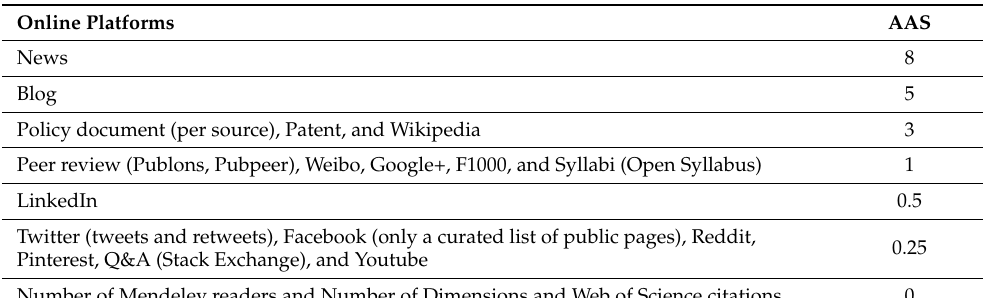
Table 1. AAS depending on the online platform. Online